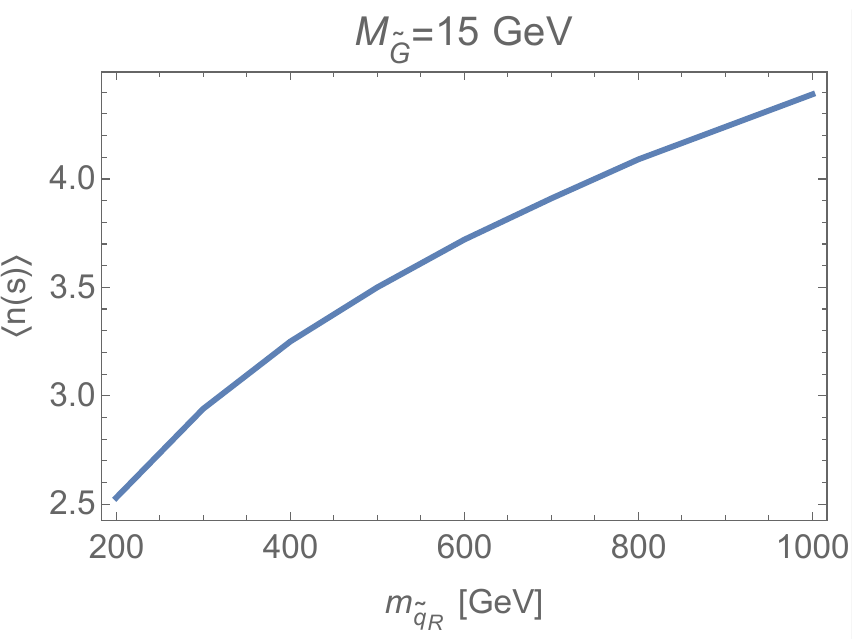
Figure 4 . Average multiplicity of glueballs as a function of energy. Here we used x M = 0 : 1 and M ~ = 15 G